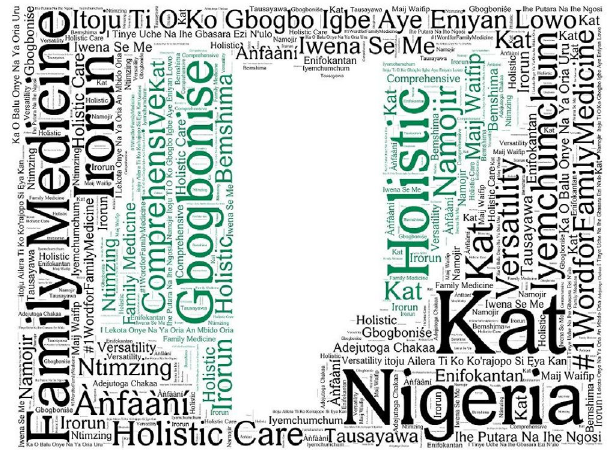
Figure 1: Word cloud image from responses in the form of the Nigerian map and